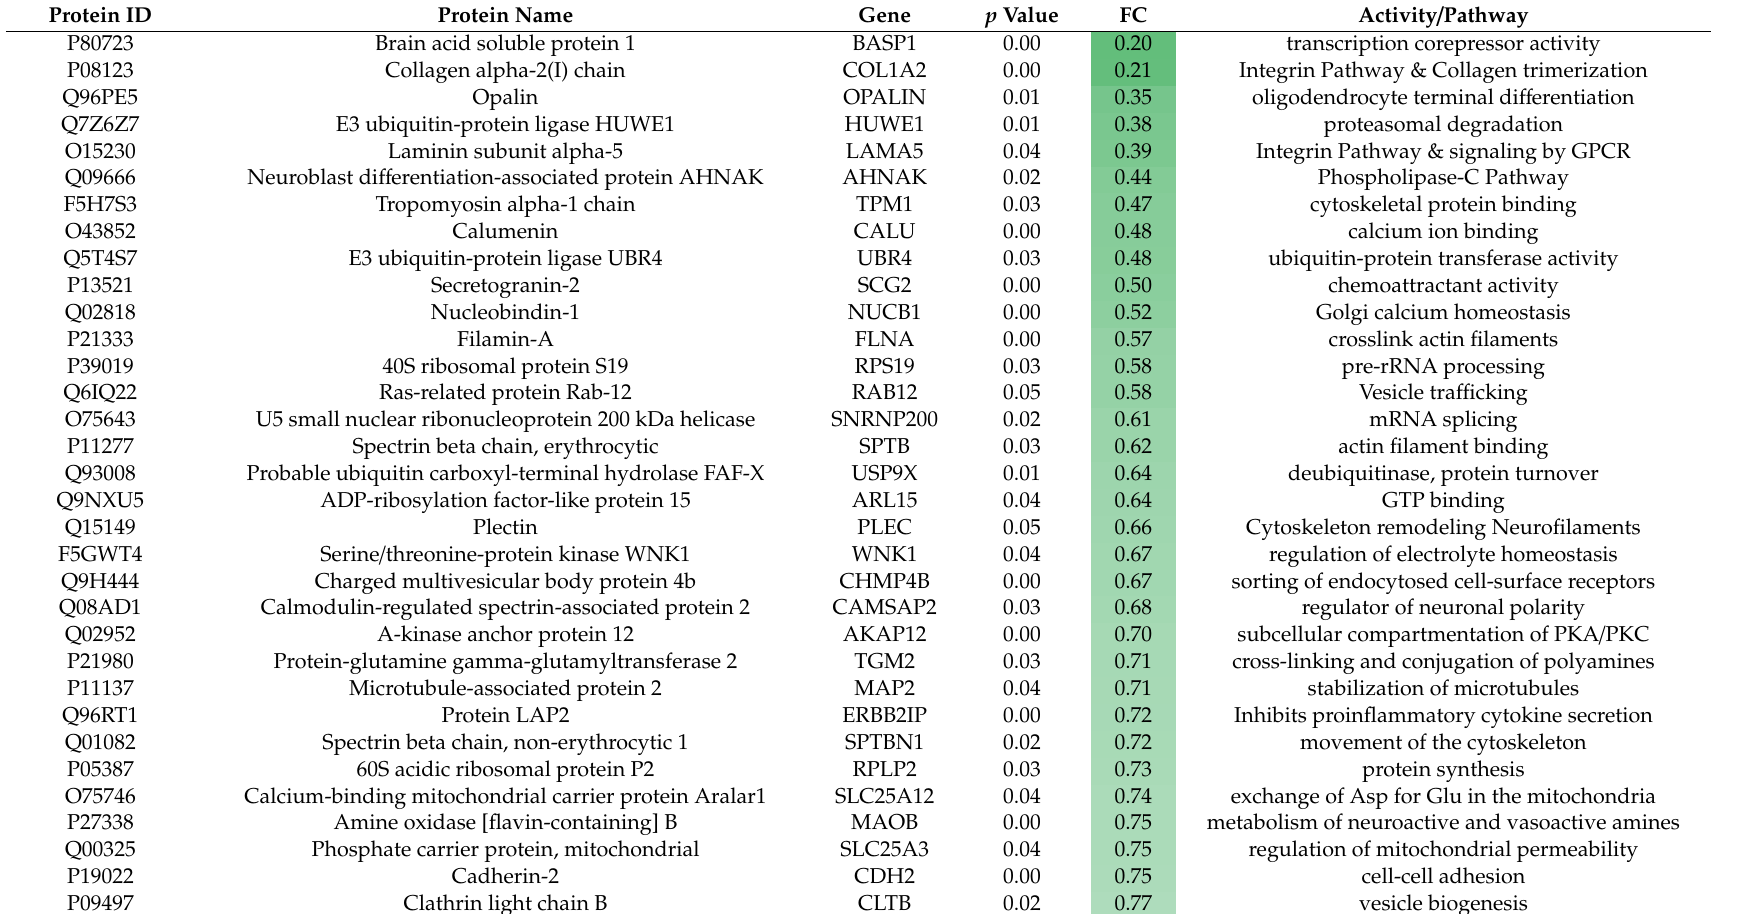
Table 1. Significantly deregulated proteins in OB derived from ALS